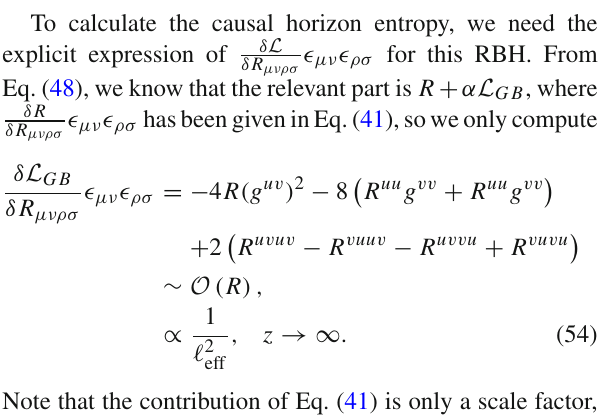
Fig. 3 The left panel shows the causal horizon entropy for z (cid:12) 1 (UV behavior), while the right panel for z (cid:13) 1 (IR behavior). The horizon- tal axes of both panels represent the affine parameter λ . We have set